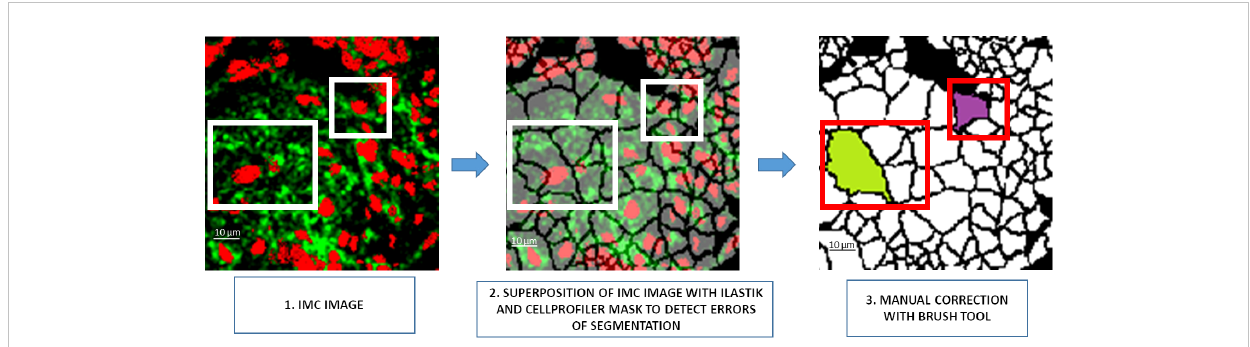
FIGURE 2 Visual interface preview for manual segmentation correction. 1. A 128×128 pixel patch of the IMC image, 2. Visualization of the segmentation mask generated by the Ilastik/CellPro fi ler pipeline to detect segmentation errors through the opacity management of the patch, 3. Manual correction of the segmentation error. IMC, Imaging Mass